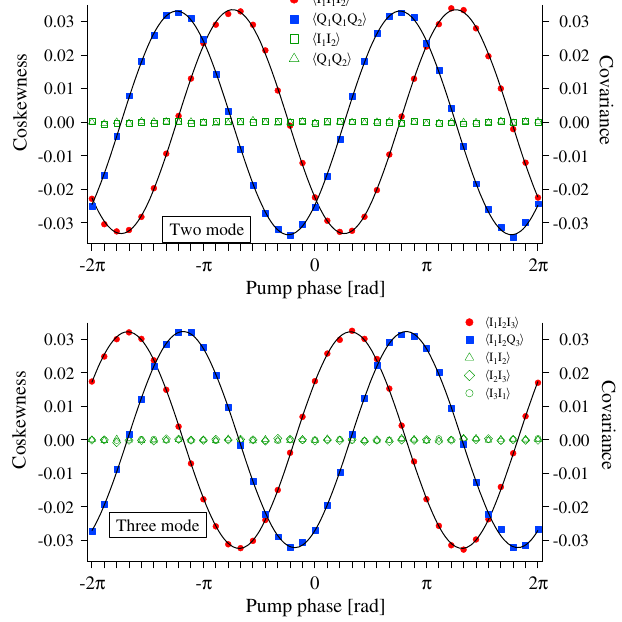
FIG. 3. Covariance and coskewness of three-photon SPDC to (top) two modes and (bottom) three modes measured at room temperature. In the two-mode case, we have a degeneracy between two of the three generated photons. This degeneracy leads to one mode participating twice in the nonzero coskewness term. For our choice of pump phase, the only significant coskewness terms are then h I 2 1 I 2 i and h Q 2 1 I 2 i . In the three-mode case, the only nonzero coskewness term must contain all three modes, e.g., h I 1 I 2 I 3 i . To show that the observed coskewness is coherently generated by the pump, we sweep the pump phase from − 2 π to 2 π and observe the effect. We see a clear oscillation in the coskewness. The oscillations are fit well by a sinusoid. Meanwhile, all covariance terms are essentially zero throughout the sweep, indicating that the generated states do not contain second-order correlations.